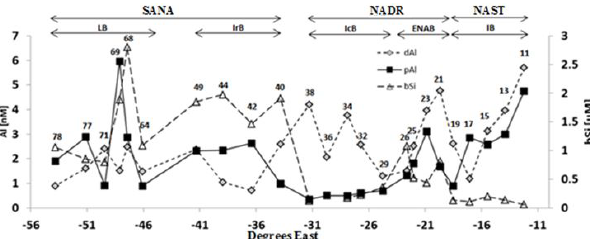
Figure 2. Average surface distribution ( < 50m) of dissolved Al (dAl), particulate Al (pAl; Gourain et al., 2018), and biogenic Si (bSi; Sarthou et al., 2018) along the GEOVIDE section. Note that stations over the Iberian and Greenland shelves are not included as they are presented in Figs. 3 and 4. LB, Labrador Basin; IrB, Irminger Basin; IcB, Iceland Basin; ENAB, East North Atlantic Basin; IB, Iberian Basin; SANA, Subarctic North Atlantic; NADR, North Atlantic Drift; NAST, North Atlantic Subtropical.